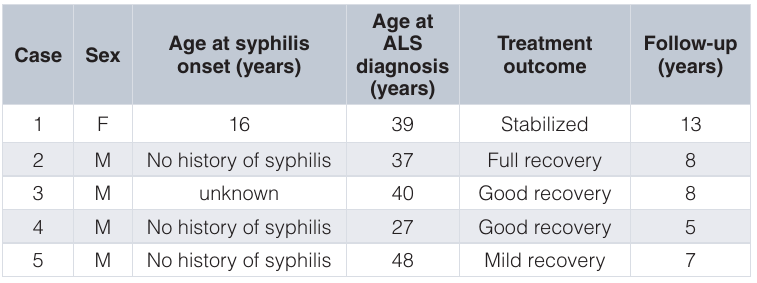
Table 1. Demographic summary reported cases on syphilitic ALS 4 .